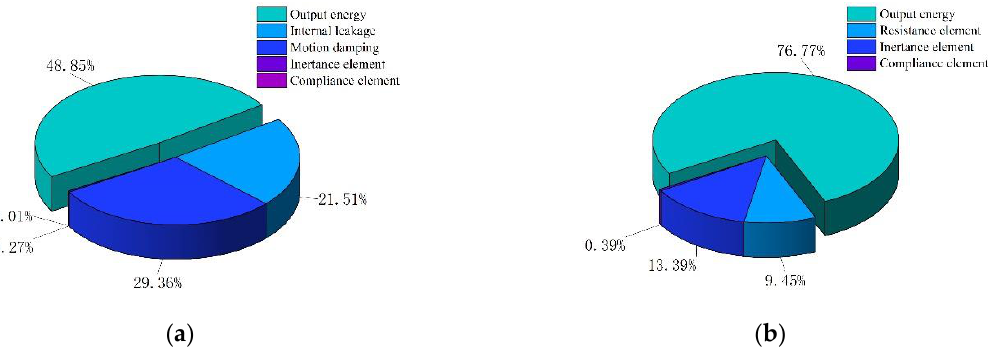
Figure 24. ( a ) The energy consumption ratio of HTD; ( b ) the energy consumption ratio of ETD.